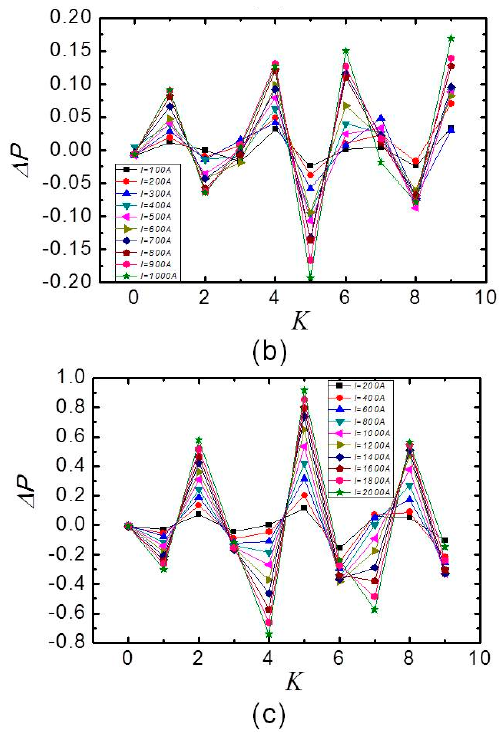
Figure 4. Variation in the output signal ∆ P versus K for ( a ) Channel 1; ( b ) Channel 2; and ( c ) Channel 3.